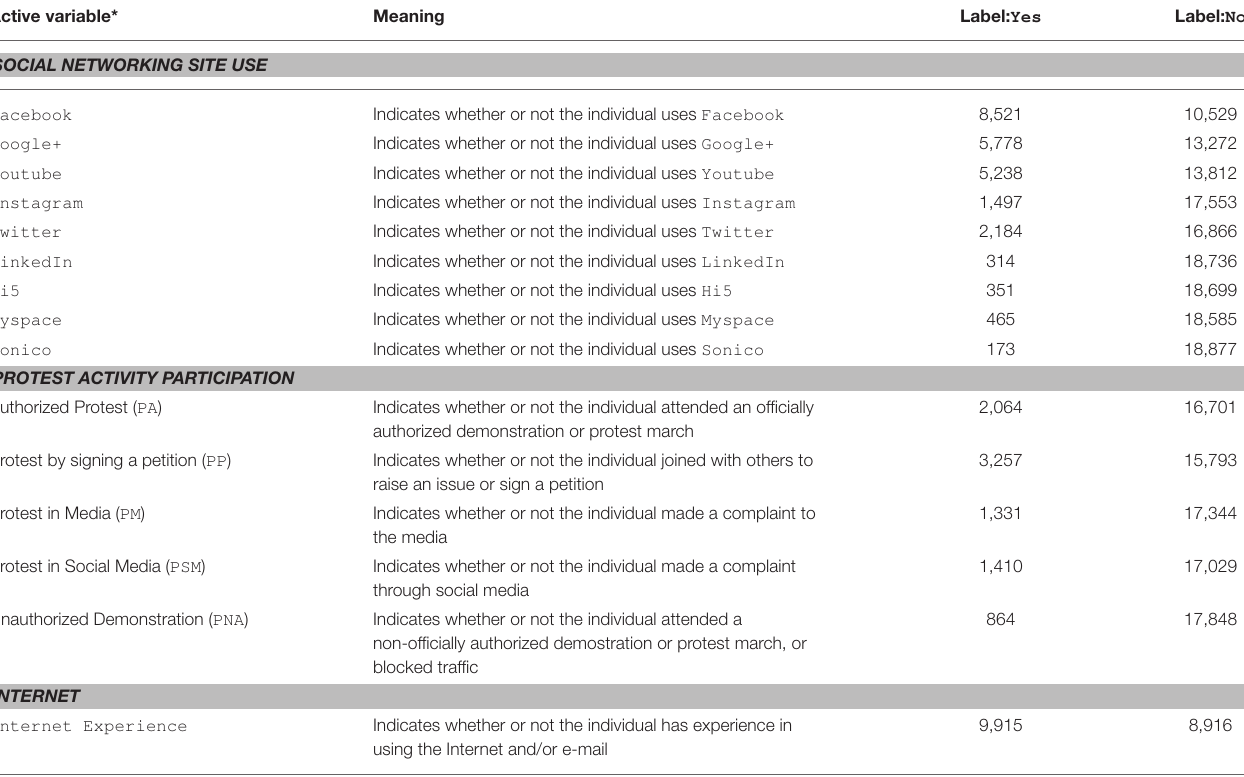
TABLE 1 | Variables for exploring the association between social networking site use usage and protest participation (count). Active variable* Meaning